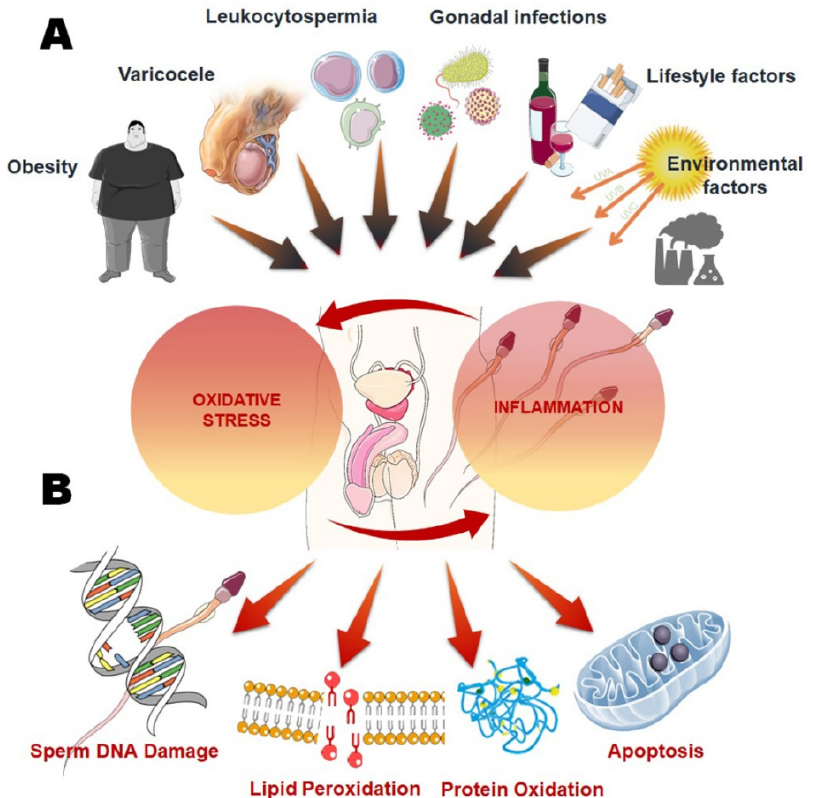
Figure 1. Inflammation and oxidative stress (OS) as core mechanisms linking common causative factors with male infertility. ( A ) Exogenous and endogenous factors impacting on male reproductive system via induction of OS and inflammation; ( B ) Effects of various causative factors mediated male reproductive disruptions mainly via oxidative damage and induction of apoptosis.